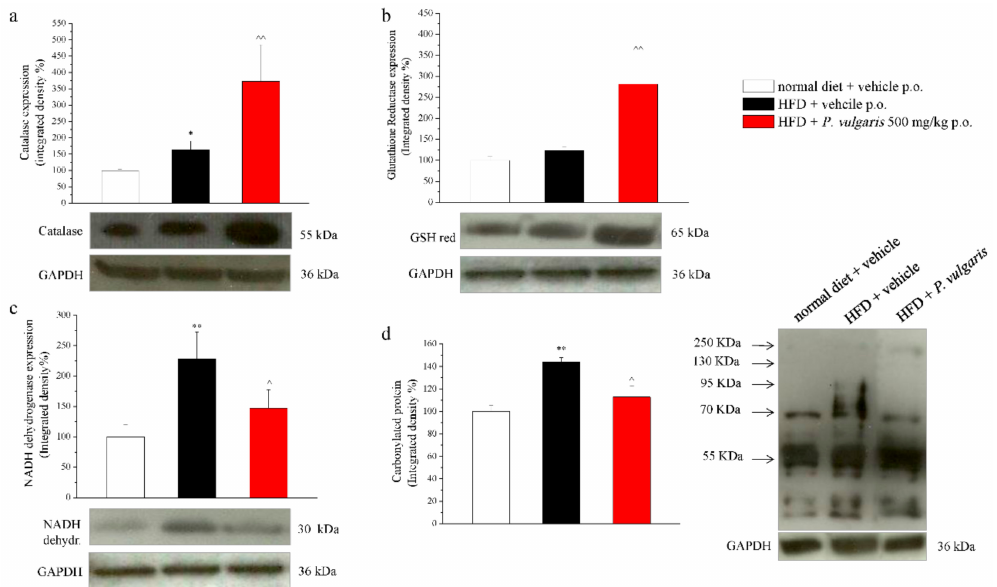
Figure 7. Cardiac damage parameters. Tissue homogenate was processed by Western blot in order to evaluate the protein expression of ( a ) catalase; ( b ) glutathione reductase; ( c ) NADH dehydrogenase; and ( d ) carbonylated proteins. Each parameter is reported as representative blot and densitometric analysis. GAPDH normalization was performed for each sample. Results are expressed as % of control group (normal diet + vehicle; 100%). Week 19. Each value represents the mean ± S.E.M. of 12 mice per group. * p < 0.05 and ** p < 0.01 vs. normal diet + vehicle; ˆ p < 0.05 and ˆˆ p < 0.01 vs. HFD +